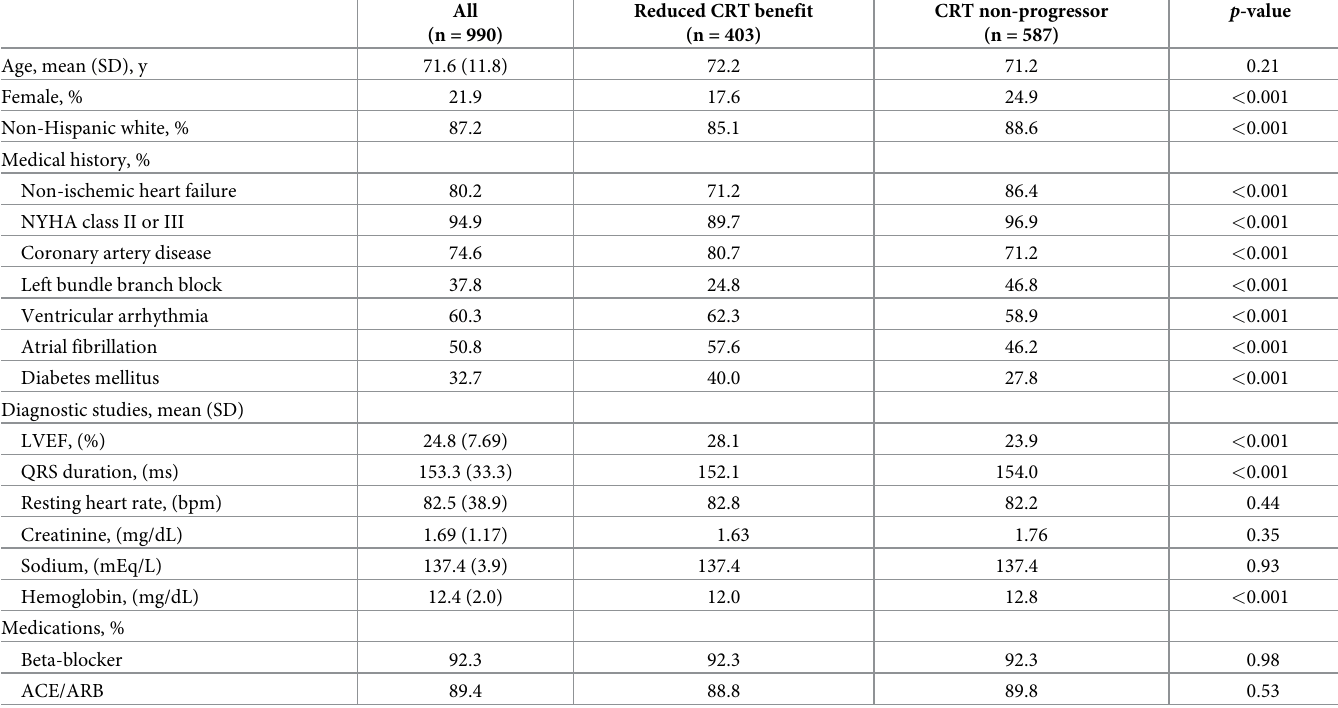
Table 2. Baseline patient characteristics. All values were obtained prior to CRT